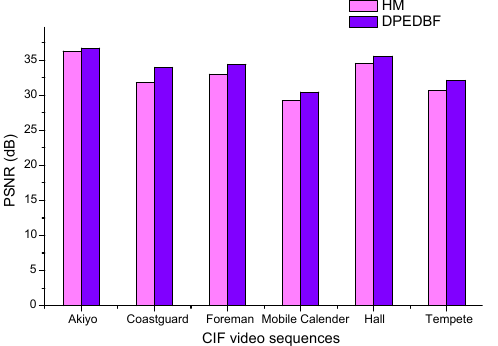
Figure 22. Comparison of PSNR with HM for CIF video sequences using QP =